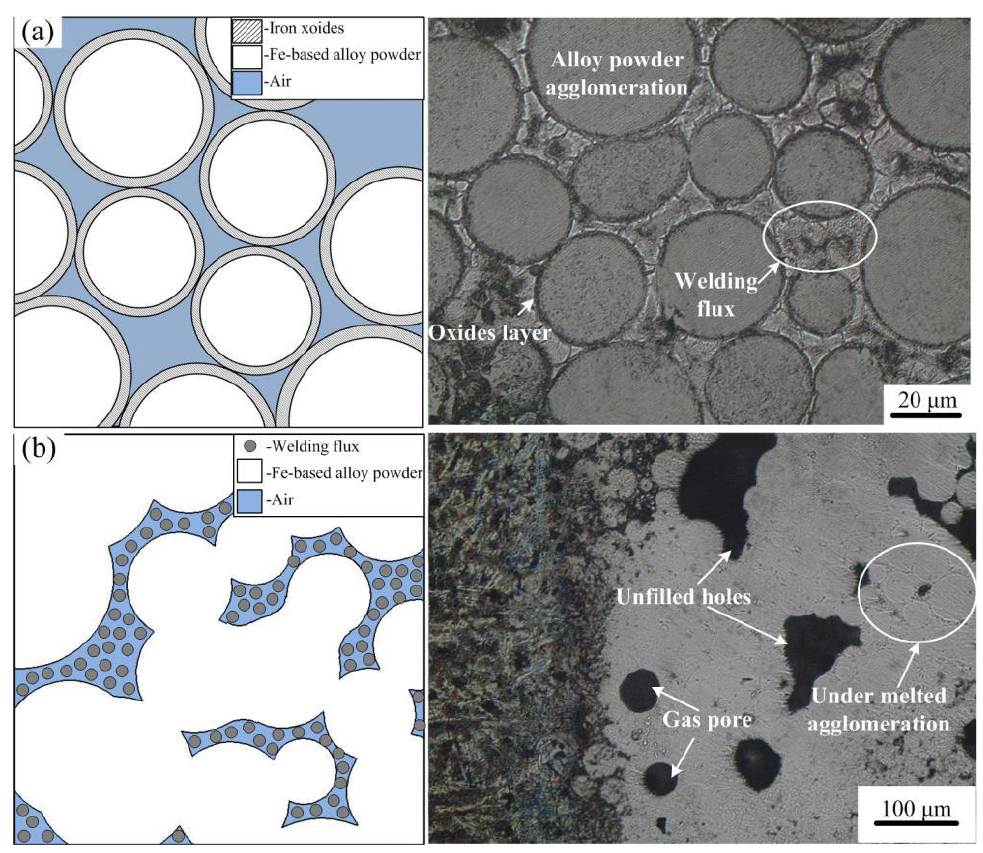
Figure 5. Schematic sketch and micrograph of the forming mechanism of Fe-based coating: ( a ) Fe-2 and ( b ) Fe-3.